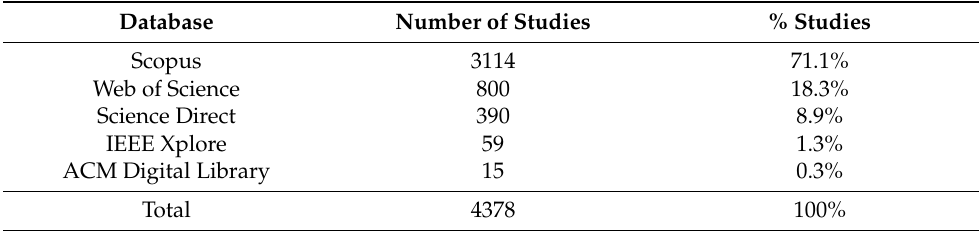
Table 2. Search results in databases using the